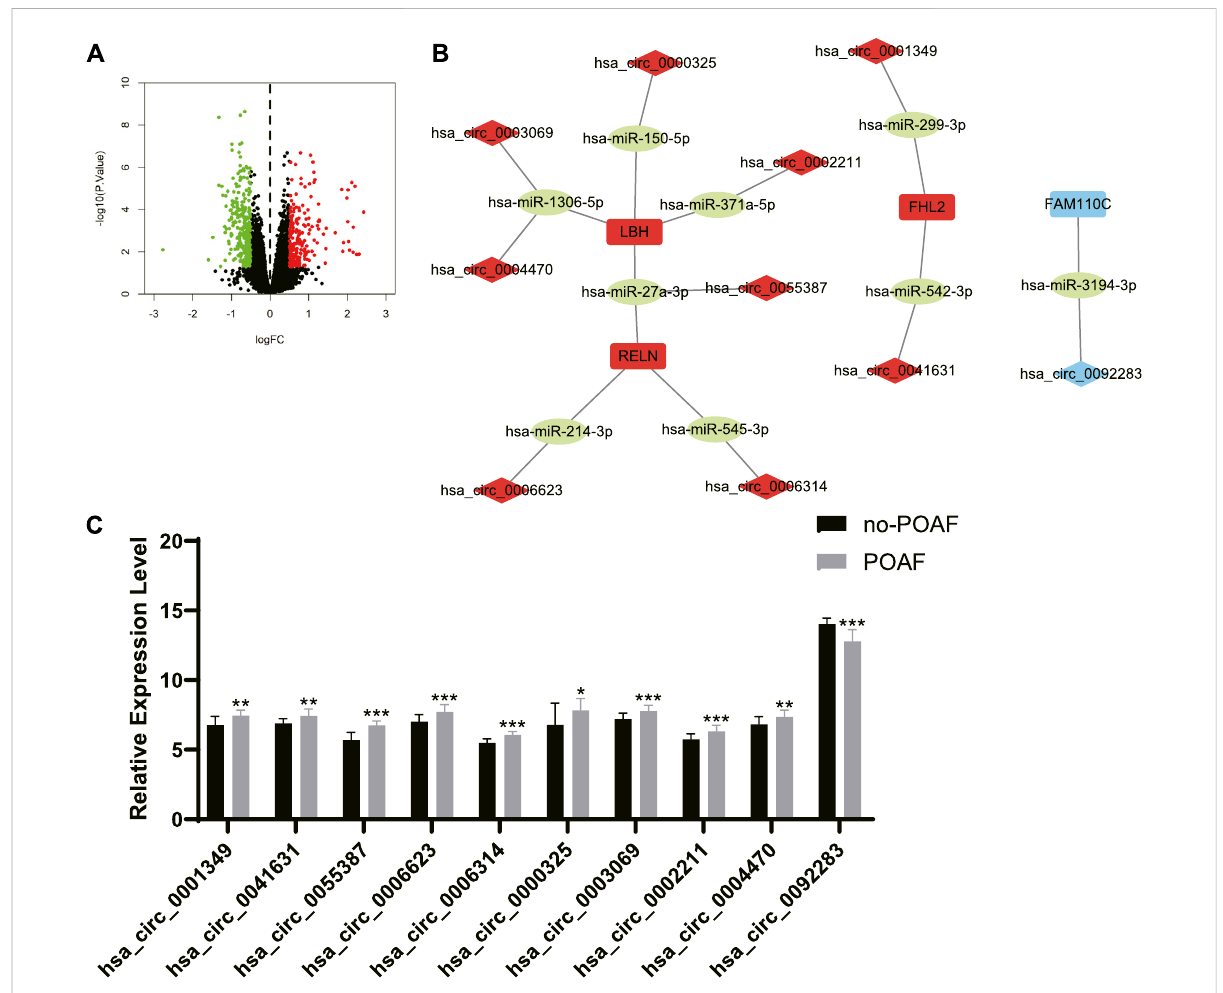
FIGURE 6 Screening of candidate circRNA biomarkers for POAF. (A) The volcano plot of differentially expressed circRNAs between patients with or without POAF. Dots in green: downregulated circRNAs, dots in red: upregulated circRNAs. (B) The ceRNA networks of DEGs after screening. The label in red: upregulated DEGs or differentially expressed circRNAs, the label in blue: downregulated DEGs or differentially expressed circRNAs, the label in green: miRNAs. (C) The expression levels of candidate circRNA biomarkers for POAF in patients with or without POAF. POAF: postoperative atrial fi brillation, DEGs: differentially expressed genes. * , p < 0.05, ** , p < 0.01, *** , p <